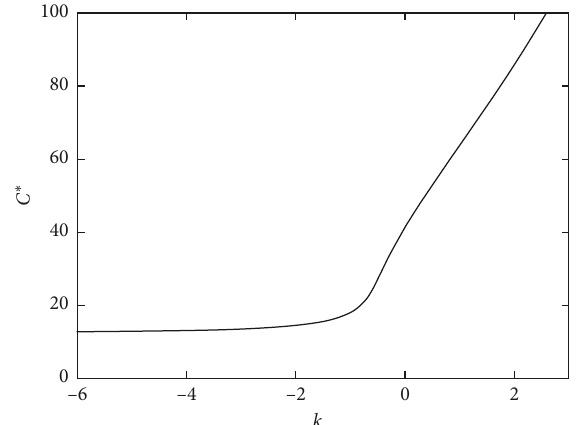
Figure 8: The curve diagram of the bifurcation critical value C ∗ with the linear gain k m